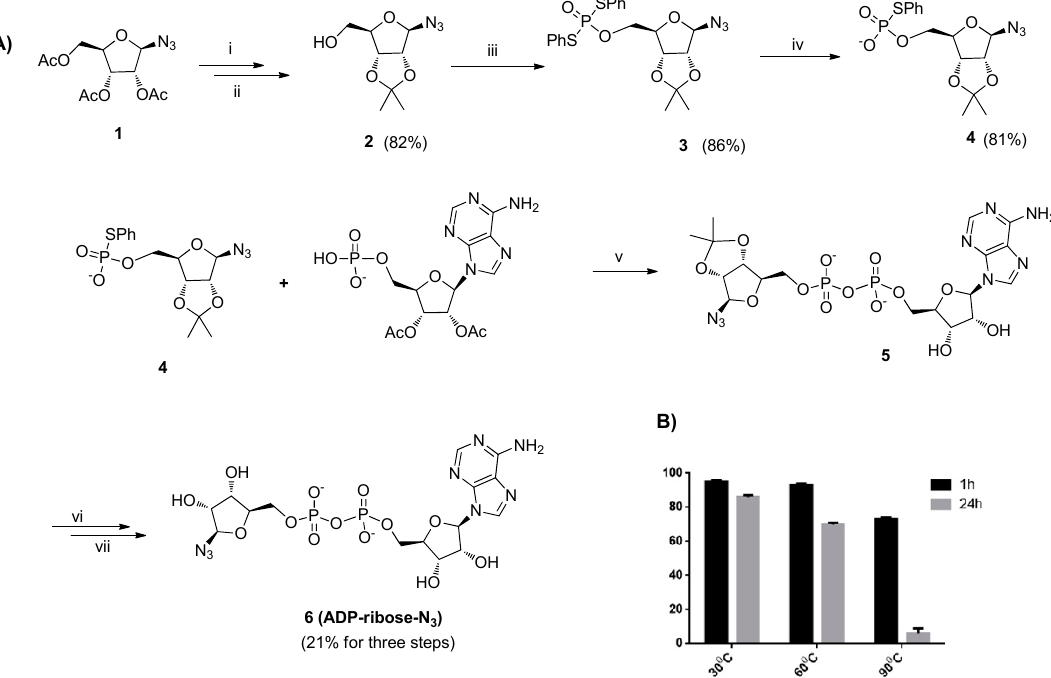
Figure 2. ( A ) Synthesis route of ADP-ribosyl-N 3 . Reagent and reaction conditions: (i) I 2 , MeOH; (ii) H + /acetone; (iii) (PhS) 2 POCl, TPSCl, tetrazole, Py; (iv) H 3 PO 2, Py; (v) I 2 , MS, Py; (vi) 30% NH 4 OH; (vii) 50% HCOOH; ( B ) The solution stability of ADP-ribosyl-N 3 . Conditions: 1 mM aqueous solution of ADP-ribosyl-N 3 was heated at given temperatures, and the resultant mixtures were detected by HPLC.